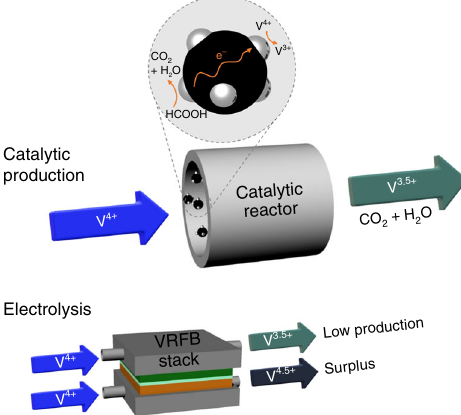
Fig. 1 Schematics for producing the V 3.5 + electrolyte. The catalytic reaction (top) and conventional electrolysis